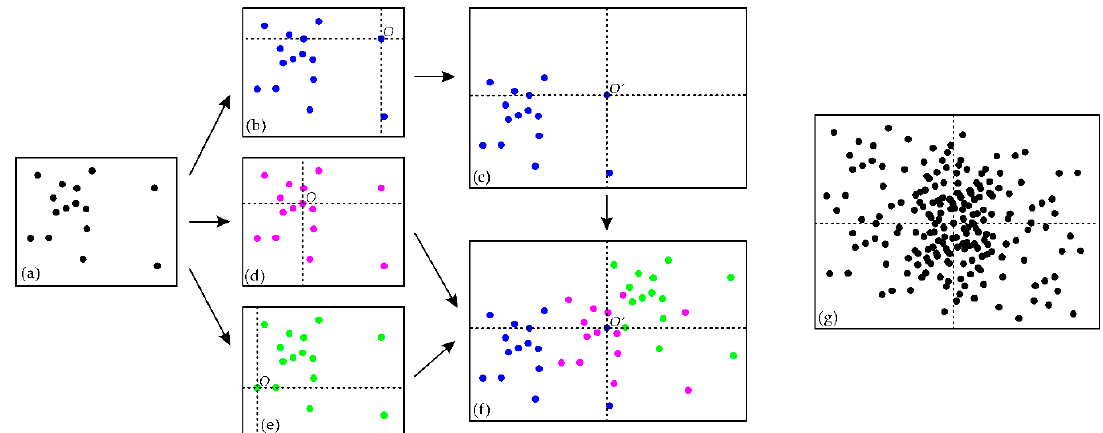
Figure 3. Schematic diagram for constructing a Fry plot: ( a ) the original sheet records raw points; ( b ) the origin O is placed on one of the raw points; ( c ) distribution pattern of raw points according to the origin O is transferred to the tracing sheet; ( d , e ) the origin O is re-placed on every raw point; ( f ) the tracing sheet records all distribution patterns of raw points with respect to different origins; and ( g ) Fry plot is constructed.